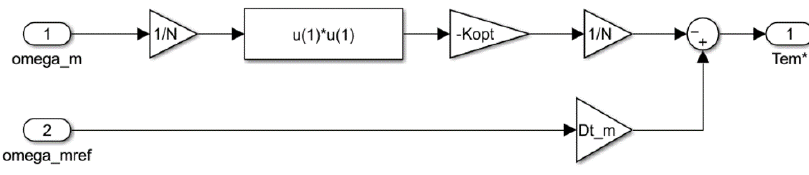
Figure 9. MPPT controller in Simulink environment.